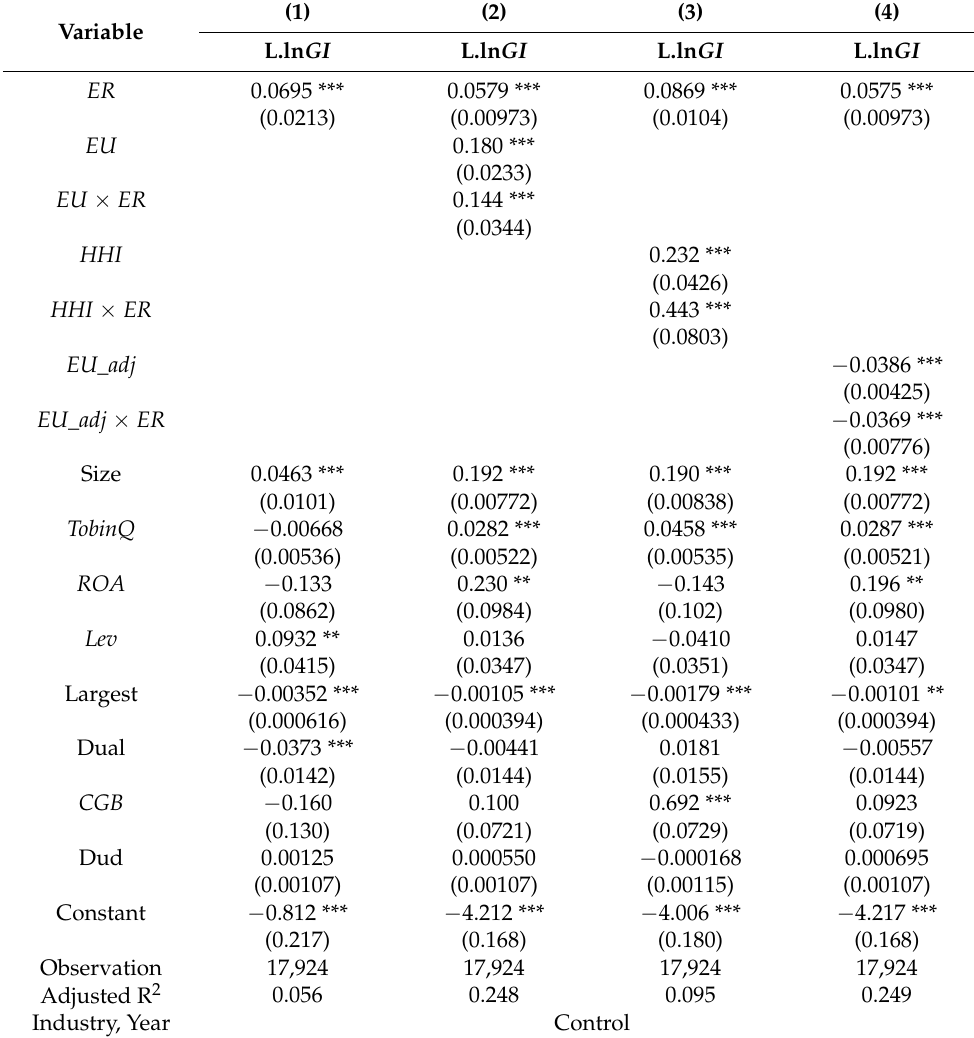
Table 13. Regression Analysis of Environmental Uncertainty, Environmental Regulation and Enter- prises’ Green Technological Innovation Lagging One